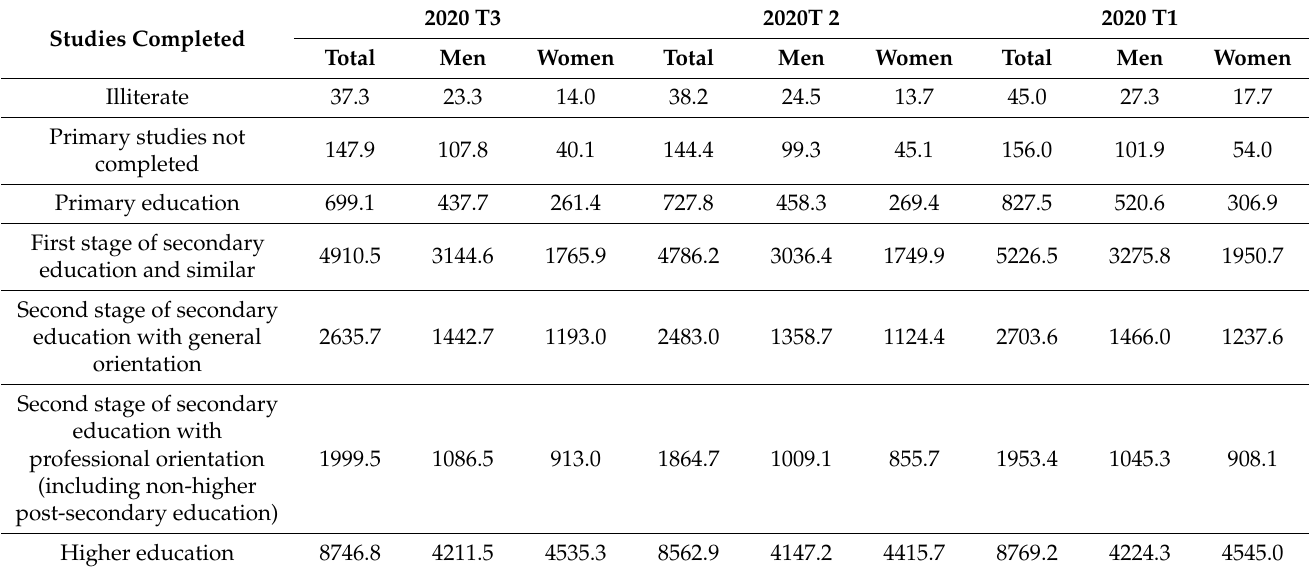
Table 5. Employed by sex and level of study (thousands of people)